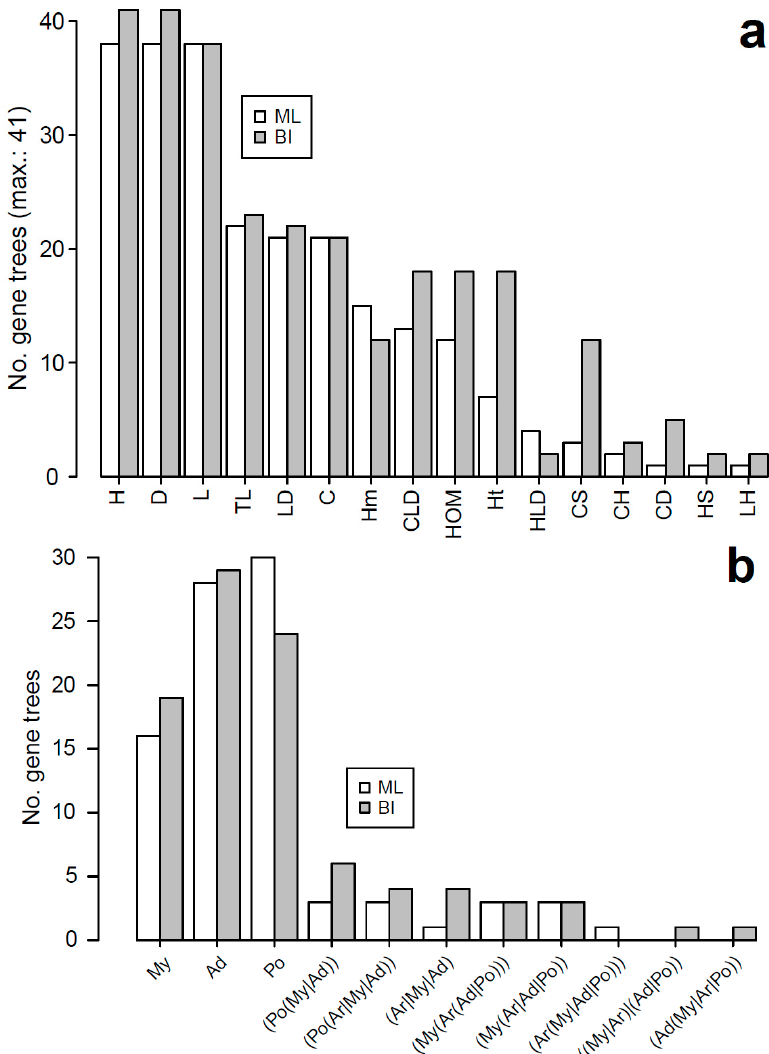
Figure 4. Frequency of maximum likelihood (ML) and Bayesian inference (BI) sperm individualization gene trees resolving particular higher taxa or relationships among them in insects ( a ) and beetles ( b ). Key: Ad, Adephaga; Ar, Archostemata; C, Coleoptera; D, Diptera; H, Hymenoptera; Hm, Hemiptera; HOM, Holometabola; Ht, Heteroptera; L, Lepidoptera; My, Myxophaga; Po, Polyphaga; S, Strepsiptera; T, Trichoptera.